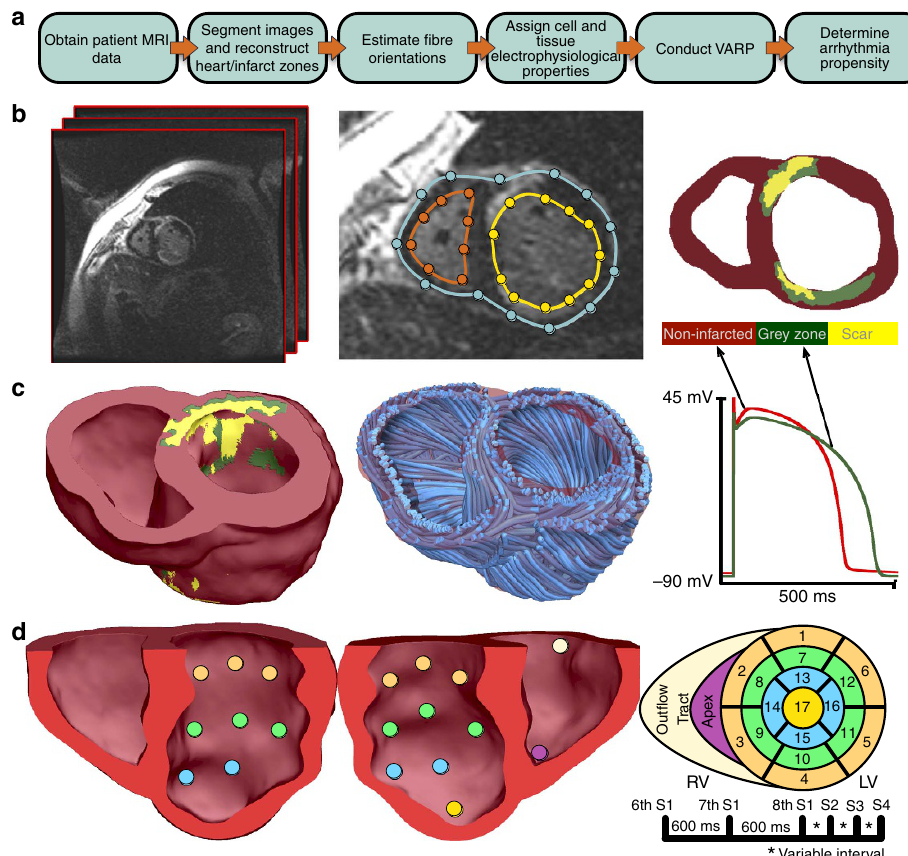
Figure 1 | VARP methodology. ( a ) Flow chart summarizing the VARP protocol. ( b ) Contrast-enhanced cardiac MRI stack (left), with landmark points and splines delineating the endocardial and epicardial surfaces (middle), respectively, and the resulting ventricular segmentation (right) into non-infarcted myocardium, grey zone and scar. ( c ) High-resolution ventricular structure model (left) with estimated fibre orientations (middle). Although fibre orientation is assigned to each finite element in the computational mesh, a tractography approach is used here to visualize the general fibre orientation. Action potential traces from the non-infarcted myocardium (red) and grey zone (green) are in right panel. ( d ) VARP pacing sites on the endocardial surface of the ventricles (left panels) and a corresponding colour schematic (right) of the myocardial wall segments (numbered), as per the American Heart Association nomenclature, in which these sites are located. The train of pacing pulses is shown on the bottom right. Additional detail is provided in